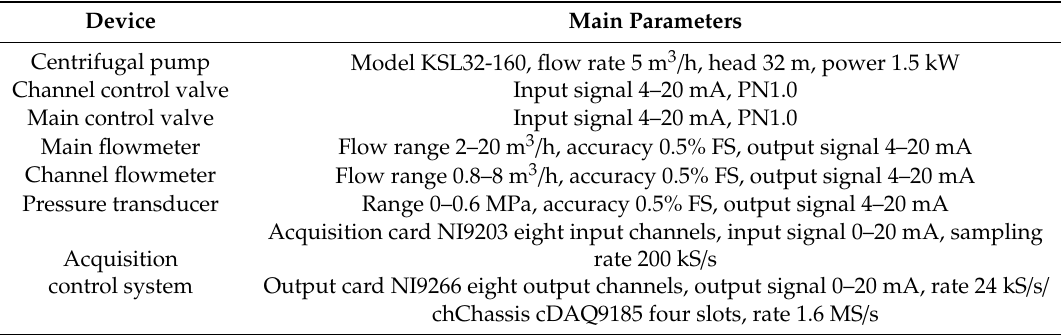
Table 1. Research platform main hardware